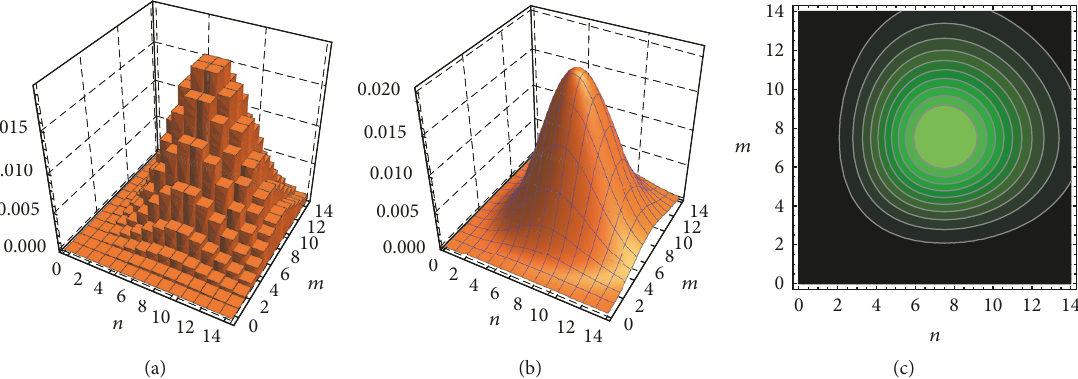
Figure 3: Using the classical state |𝑧,0⟩ as input in the beam splitter of Figure 2, the probability P (𝑛,𝑚,|𝑧|) of detecting 𝑛 and 𝑚 photons at the horizontal and vertical output ports is factorizable as the product of two independent Poisson distributions (51). The figures (a) and (b) correspond to the distribution P (𝑛,𝑚, 4) obtained for an input signal with ⟨̂𝑛⟩ = 16 , and (c) shows some of its level curves, respectively.